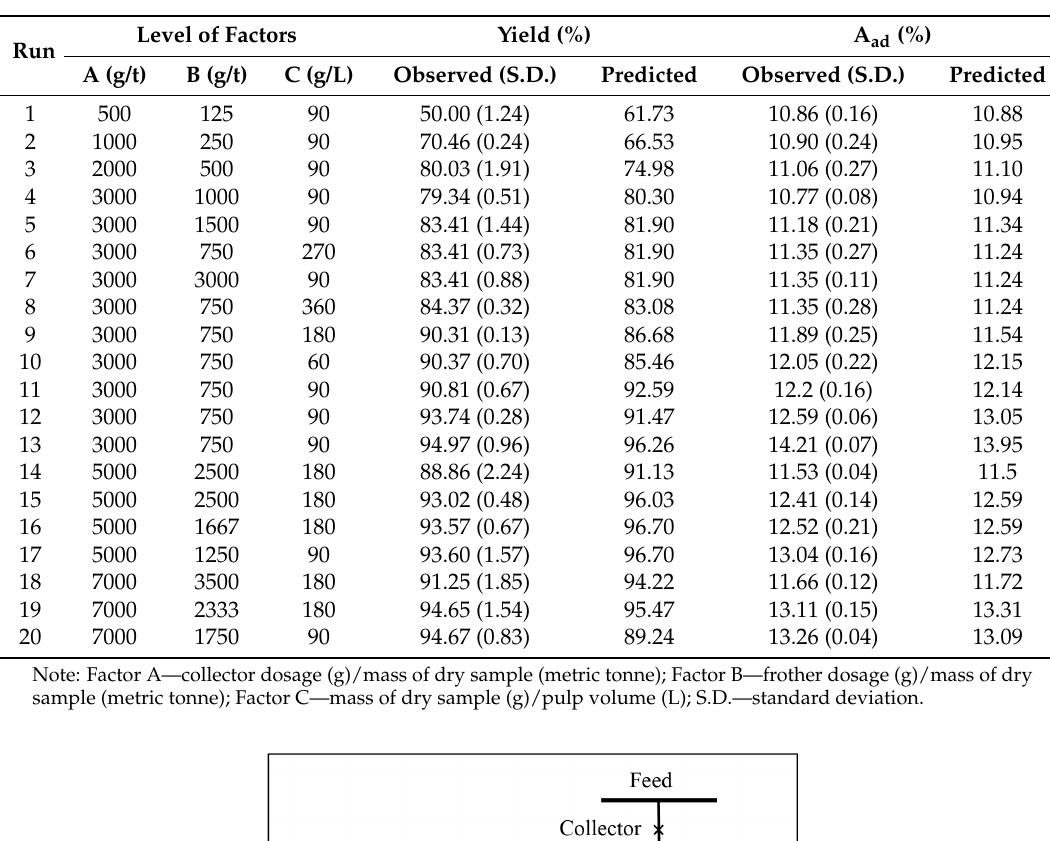
Table 2. Levels of factors A, B, and C together with experimental and predicted results of the mechanical flotation cell.